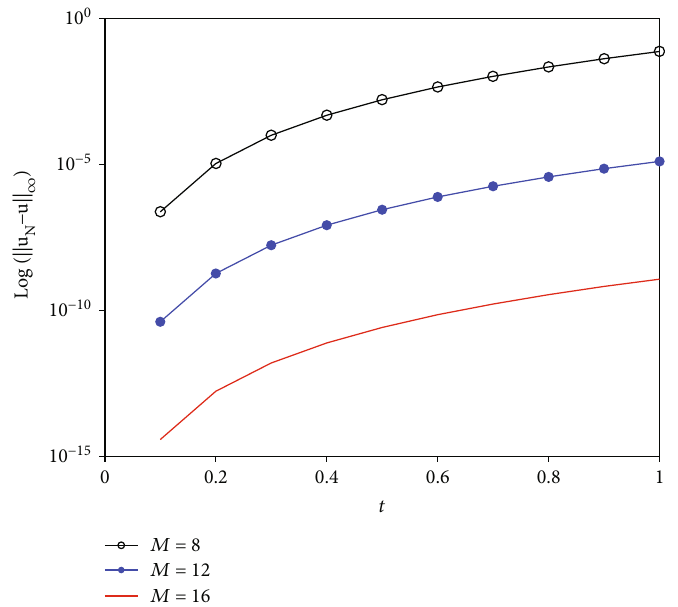
Figure 2: The maximum absolute error with di ff erent M and N = 16